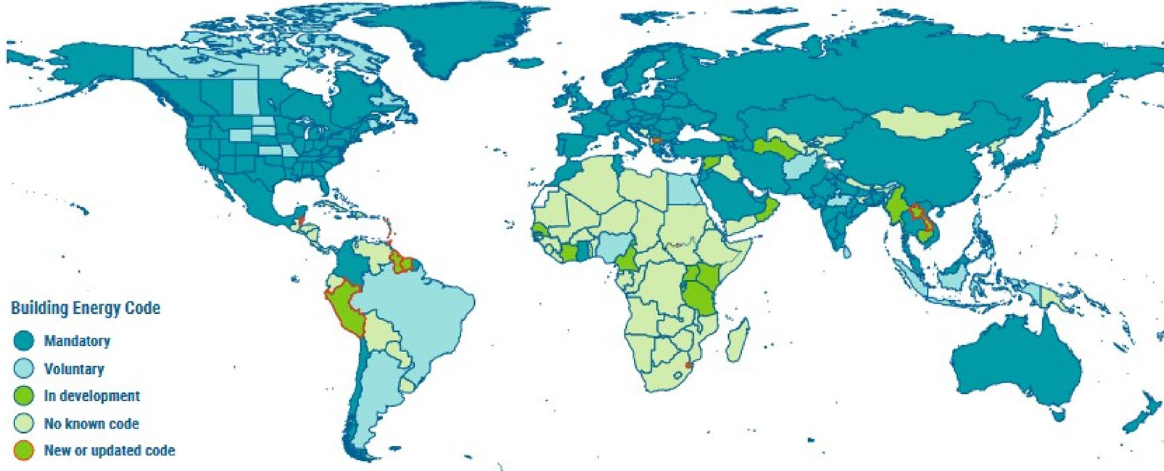
Fig. 9 Status of building energy codes across different nations and states